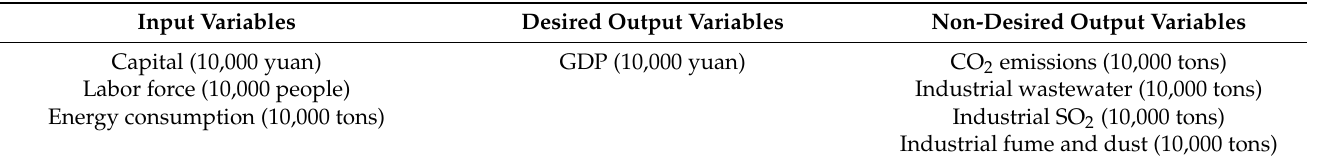
Table 1. Input–output